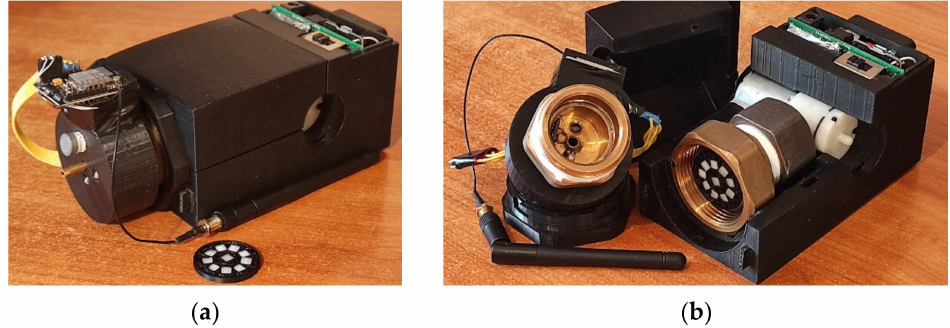
Figure 11. Fluorescence recorder and cartridge used in the experiment: assembled ( a ) and disassem- bled ( b